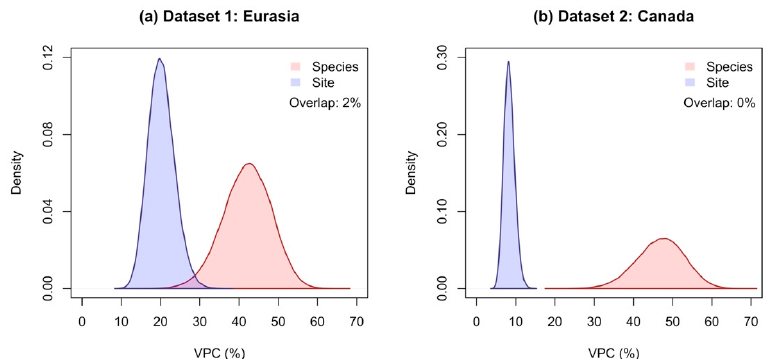
Figure 2. The Variance Partition Coefficient (VPC) density, for Dataset 1 ( a ) and Dataset 2 ( b ). Note: The density curves are based on VPC values resulted from bootstrap analysis; the ‘overlap’ shows the percentage of the overlapping regions of the two distributions.